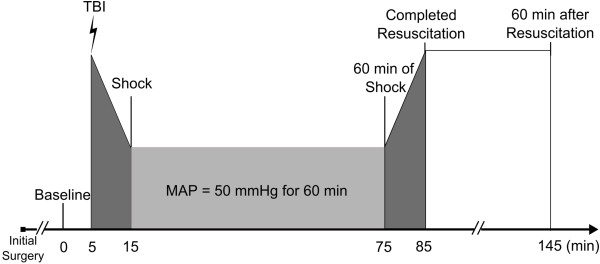
Experimental protocol and flow of experiments.